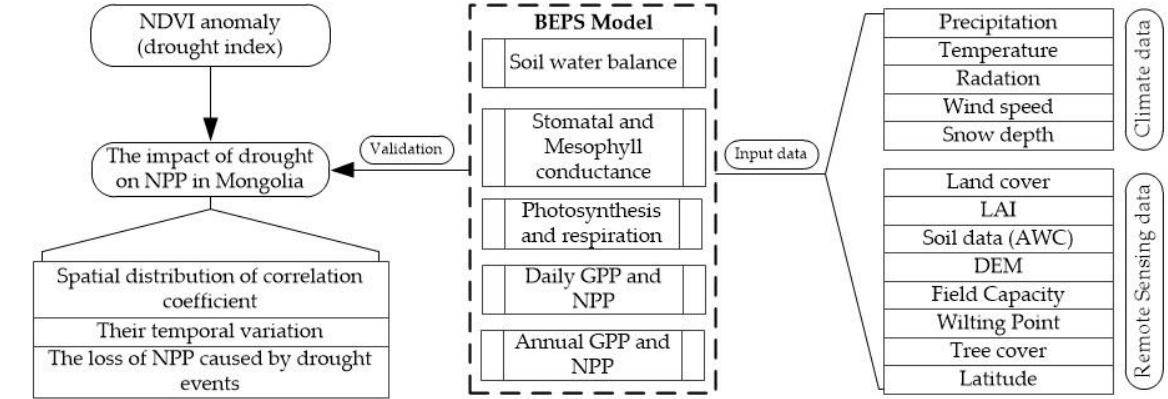
Figure 2. Methodological flow chart for NPP (net primary productivity) response to drought events. NDVI, normalized difference vegetation index; BEPS, Boreal Ecosystem Productivity Simulator; GPP, gross primary productivity; AWC, available soil water-holding capacity; DEM, digital elevation model.